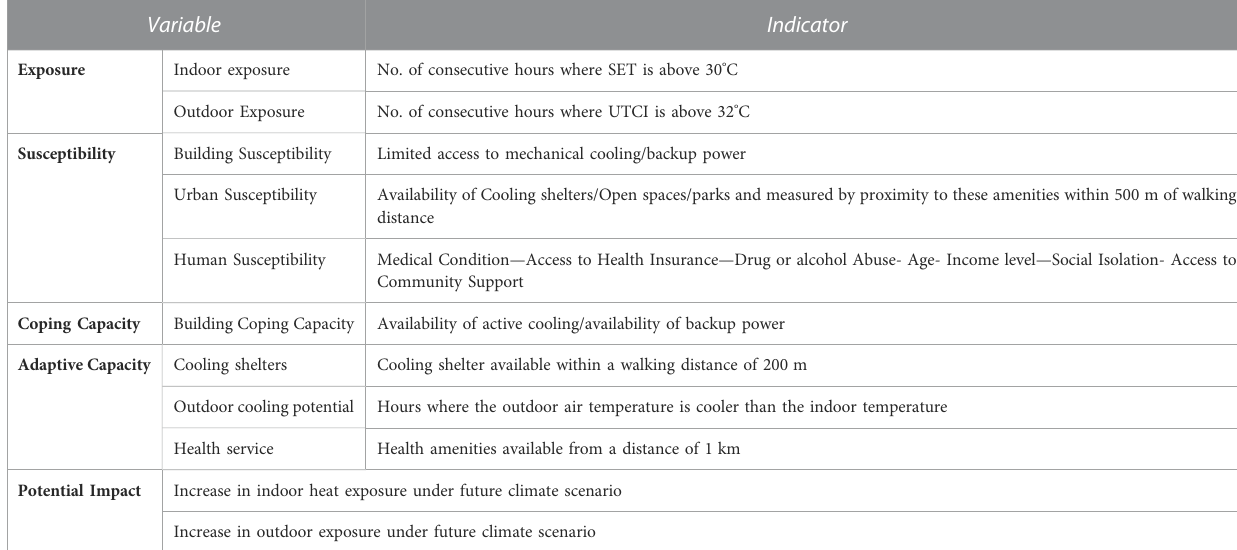
TABLE 1 System variables and their indicators. Variable